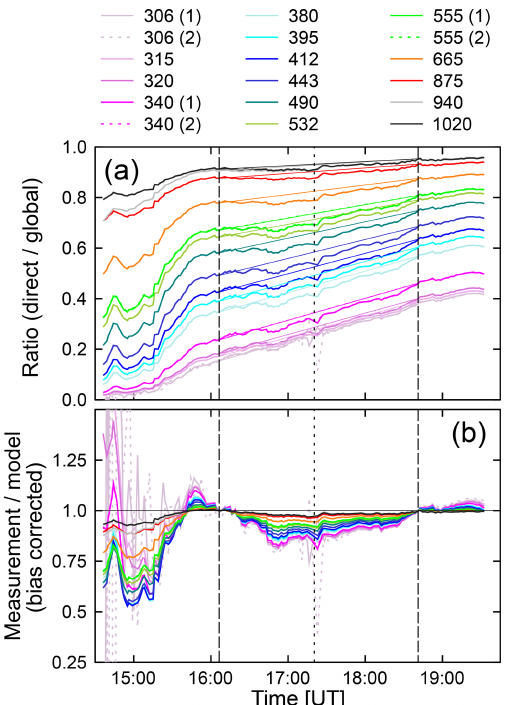
Figure 11. (a) Ratio of direct-to-global spectral irradiance. Mea- surements are shown as heavy lines. Thin lines connect measure- ments at the start of end of the eclipse and are drawn to guide the eye. (b) Ratio of the measured and modeled direct-to-global ratios, corrected for the bias between measurement and model. Numbers (1) and (2) in the legend indicate the channel number for channels equipped with identical